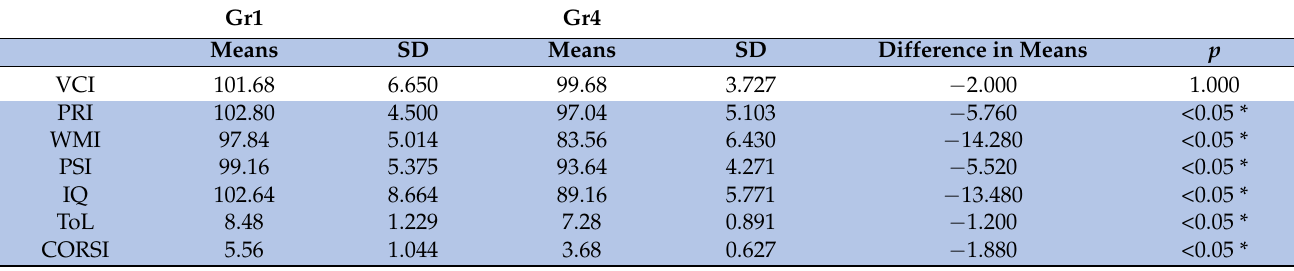
Table 3. Post hoc between Gr1 and